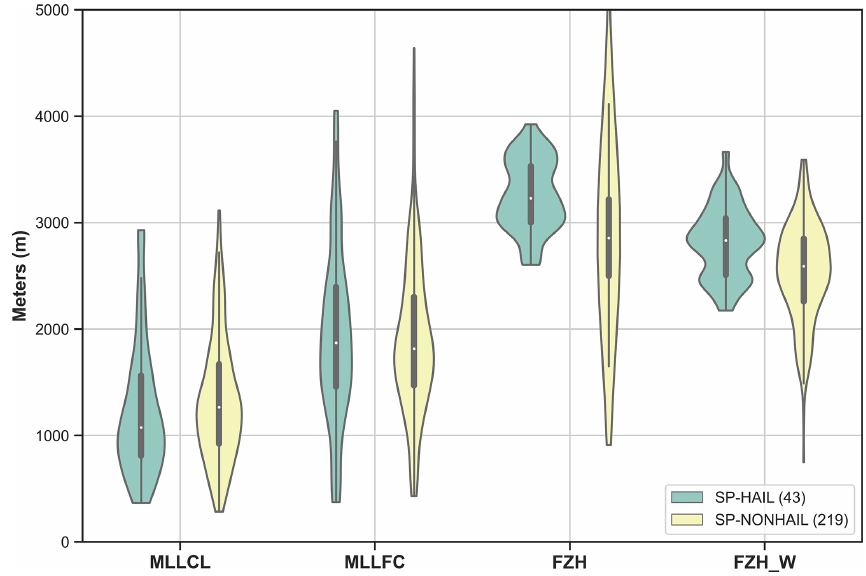
Figure 9. As in Fig. 7, but for MLLCL, MLLFC, FZH and FZH_W.